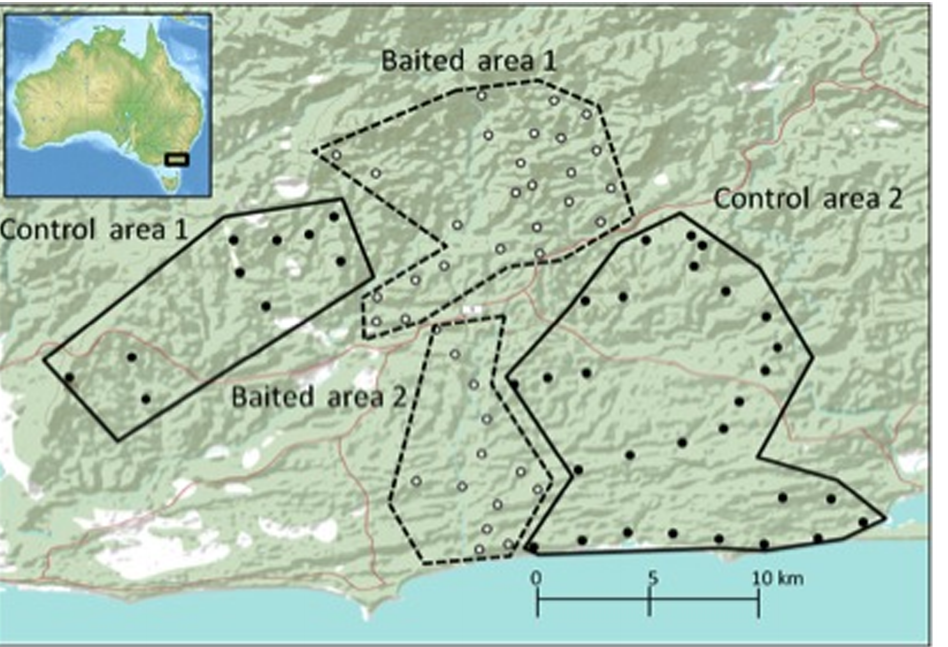
Figure 2. Map of the Cape Conran Coastal Park and Murrungowar state forest study region, situated in Far East Gippsland, Victoria (37 6 48 9 S 148 6 52 9 E). Dots indicate the locations of the 76 transect lines used for trap and sand pads to sample the lace monitor ( Varanus varius ). Colour of dots indicates treatment area; black represents fox ( Vulpes vulpes ) suppression areas (baited with 1080 poison) with low densities of V. vulpes , white represents control areas (baited with non-toxic baits) with high densities of V. vulpes .